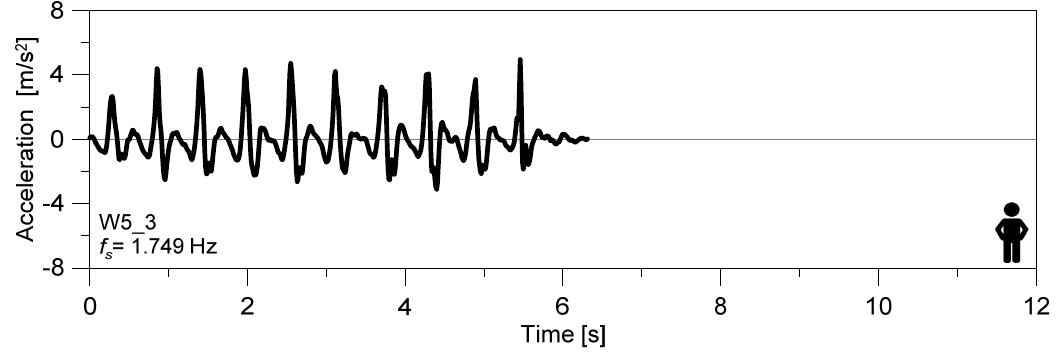
Figure 13. Example of experimental body CoM accelerations in time (W5 selection) for the volunteer on SLAB#1.